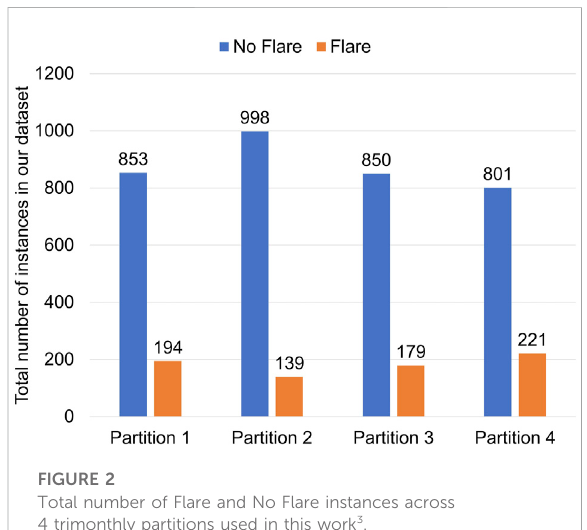
FIGURE 2 Total number of Flare and No Flare instances across 4 trimonthly partitions used in this work 3